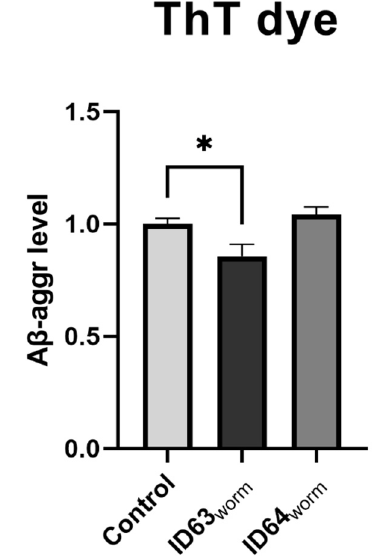
Figure 10. The effect of either ID63 worm or ID64 worm on the accumulation of aggregated A β (A β -aggr) in GMC101 after 48 h incubation. The treatment of the nematodes with ID63 leads to a significant reduction of accumulated A β . Whereby the treatment with ID64 combination did not lead to an alteration of A β levels; N = 8; mean ± SEM; one-way ANOVA with Tukey’s comparison post hoc test. * p < 0.05. ID63 worm = Fol 50 µ M and MgOr 100 µ M; ID64 worm Fol 50 µ M, MgOr 100 µ M and Vit B6 100 µ